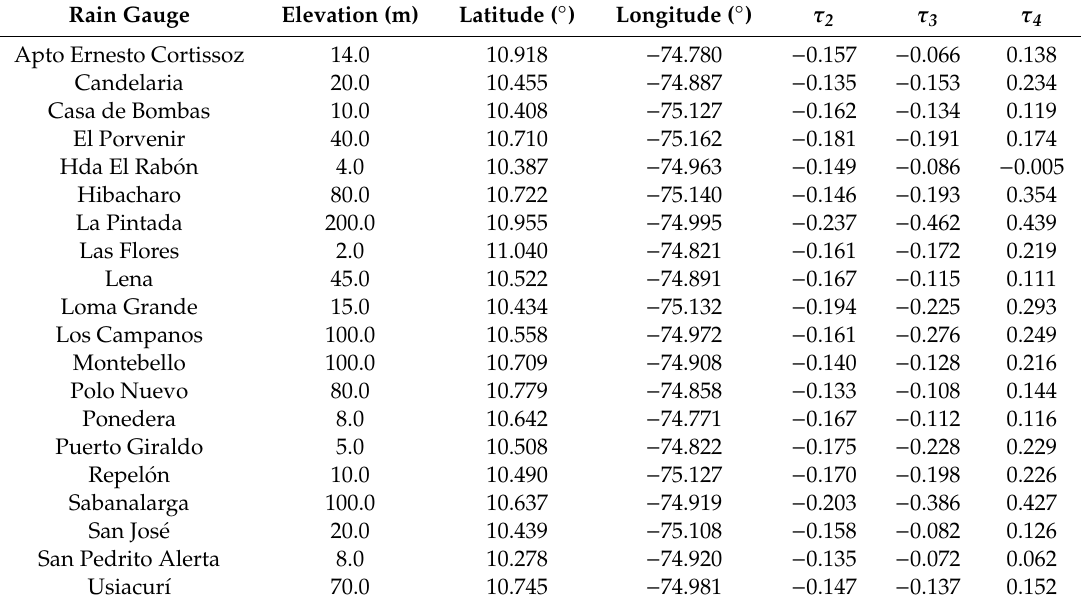
Table 5. Dimensionless L-moments.